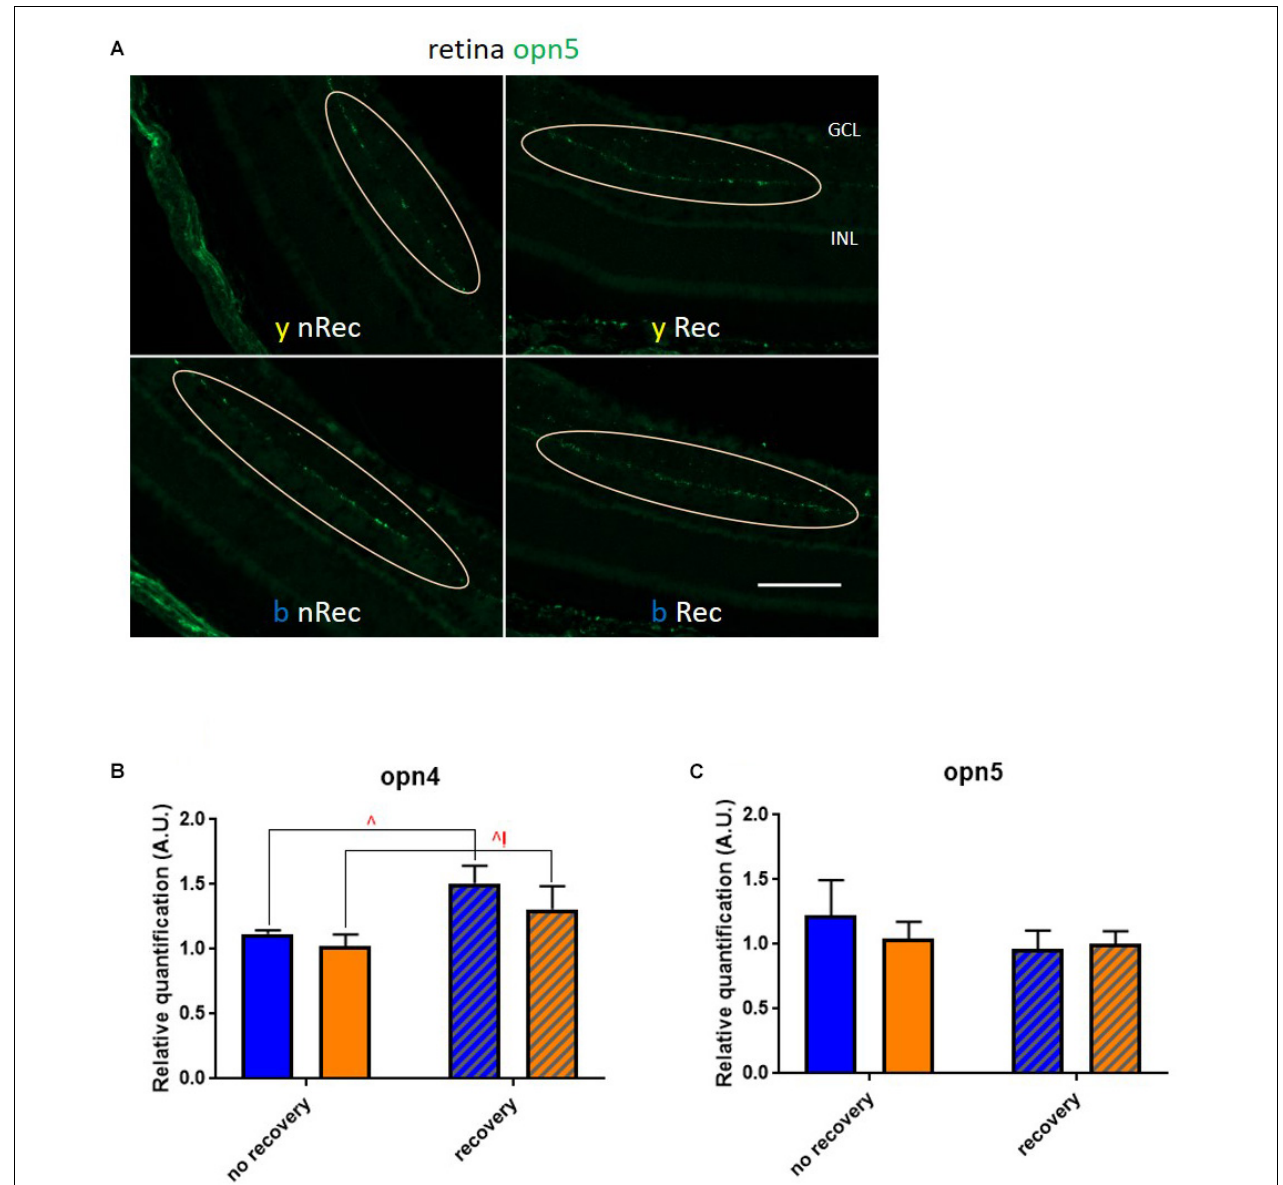
FIGURE 8 | Role of retinal photoreceptors (2). (A) Immunohistochemistry was performed on the retinas of blue- ( b ) and yellow-exposed ( y ) mice either immediately after illumination ( nRec ) or in 3 days of recovery ( Rec ). Results of anti-opn5 ( C , localization of neuropsin-expressing cells is circled) staining is presented. Magnification is 20 × , scale bars corresponds to 100 µ m. (B,C) Results of RT-qPCR analysis on the retinas: mRNA expression of opn4 ( B ; blue no recovery vs. recovery – q = 0.0174, p = 0.0166; yellow no recovery vs. recovery – q = 0.0499, p = 0.0951) and opn5 (C) . Blue and yellow bars correspond to blue and yellow exposures, respectively; clear and hatched bars correspond to the time points of dissection, either directly after illumination ( no recovery ) or in 3 days of recovery ( recovery ), respectively. All data are presented as mean ± SEM. Differences were considered significant when p < 0.05 ( ∗ / ∧ ), p < 0.01 ( ∗∗ / ∧∧ ), p < 0.001 ( ∗∗∗ / ∧∧∧ ) or p < 0.0001 ( ∗∗∗∗ / ∧∧∧∧ ). Carets correspond to comparison of mice assessed directly after illumination to the ones assessed after 3 days of recovery, within the same spectra. Red color means increase and blue color decrease in